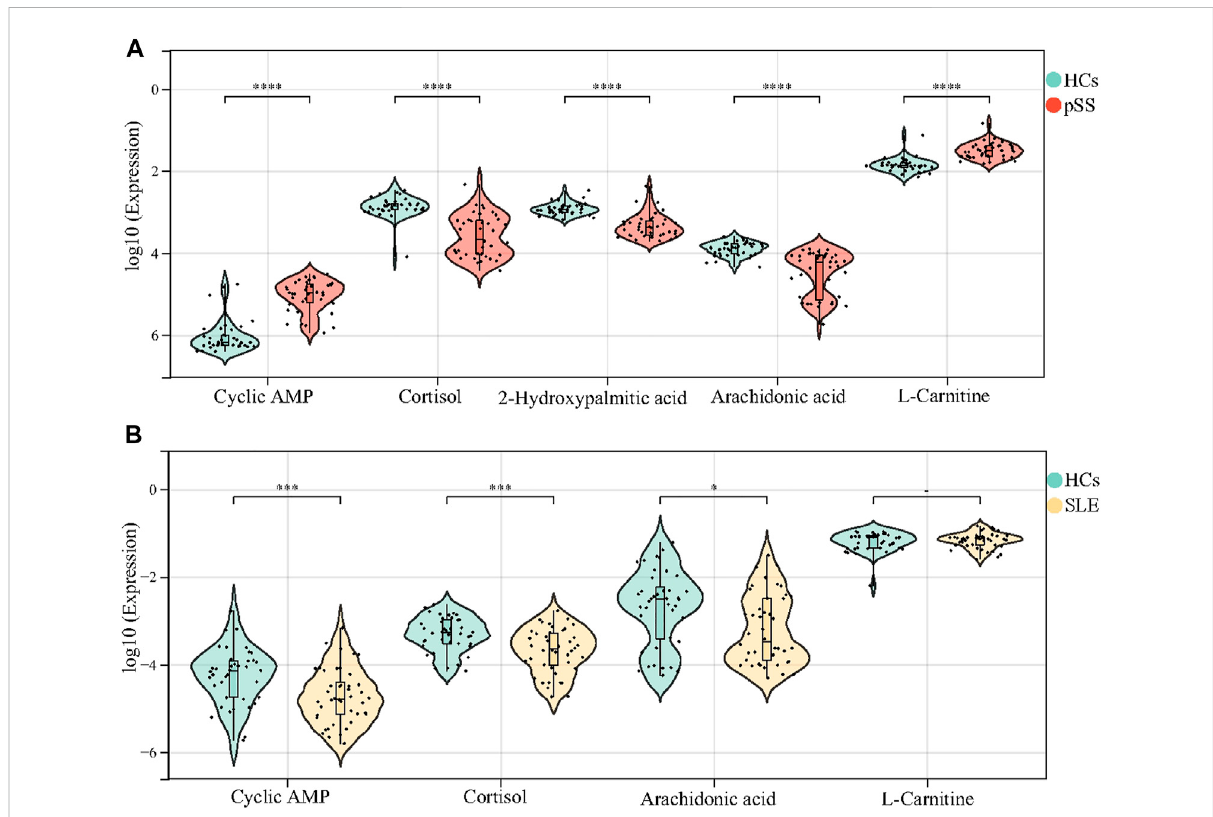
FIGURE 5 Validation of cAMP, cortisol, 2-Hydroxypalmitic acid, arachidonic acid and L-Carnitine in the SLE cohort. The levels of cAMP and L-Carnitine in patients with pSS decreased signi fi cantly compared with HCs, while the levels of cortisol, 2-Hydroxypalmitic acid and arachidonic acid inceased (A)